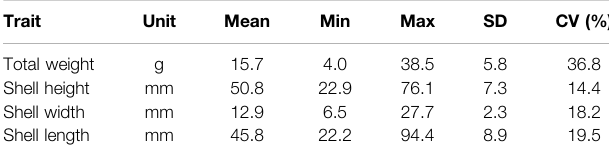
TABLE1| Summarystatisticsofthephenotypicdata(SD:Standarddeviation;CV: coef fi cient of variation). Trait